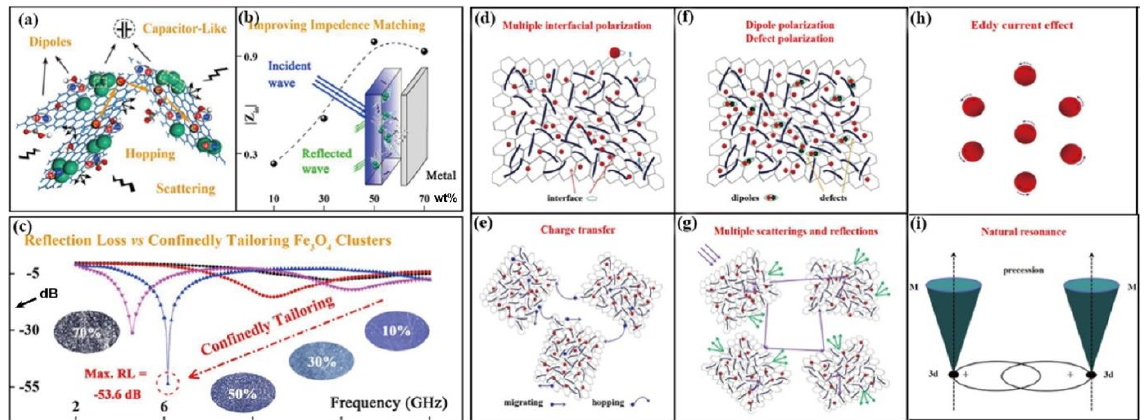
Figure 5. ( a ) EM wave response, ( b ) | Z in | and ( c ) RL of the Fe 2 O 3 -GN. Reproduced with permission from Wang et al. [84], Confinedly tailoring Fe 3 O 4 clusters-NG to tune electromagnetic parameters and microwave absorption with broadened bandwidth; published by Elsevier, 2018. Schematic of ( d ) multiple polarization, ( e ) charge transfer, ( f ) dipole and defects polarization, ( g ) multiple scatterings and reflections, ( h ) eddy current, and ( i ) natural resonance of the RGO/thorns-like PANI/ α -Fe 2 O 3 @SiO 2 nanocomposites. Reproduced with permission from Zhang et al. [85], Synthesis of graphene/thorns- like polyaniline/ α -Fe 2 O 3 @SiO 2 nanocomposites for lightweight and highly efficient electromagnetic wave absorber; published by Elsevier, 2018.